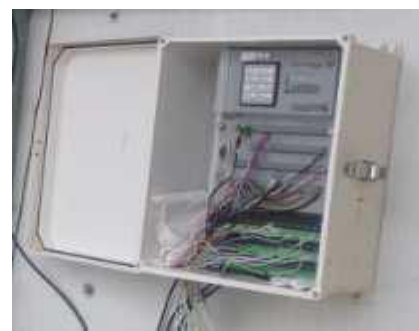
Figure 3. HMP155A sensor.